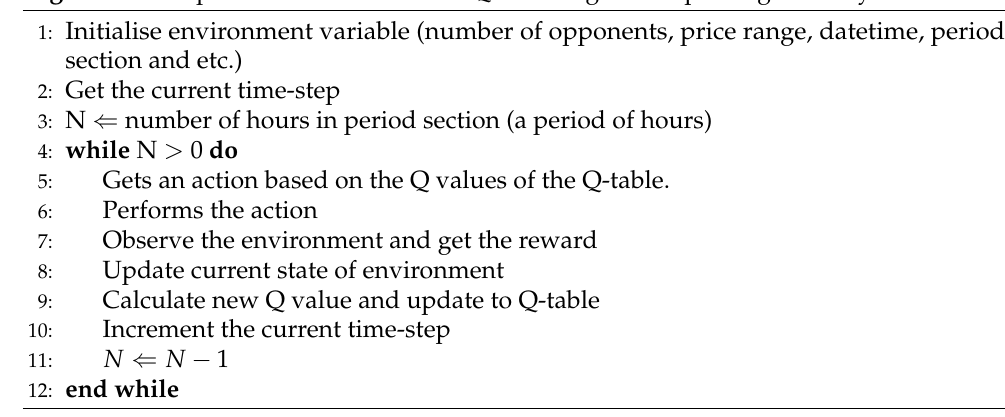
Algorithm 1 Implementation of RL with Q-Learning for the parking industry.